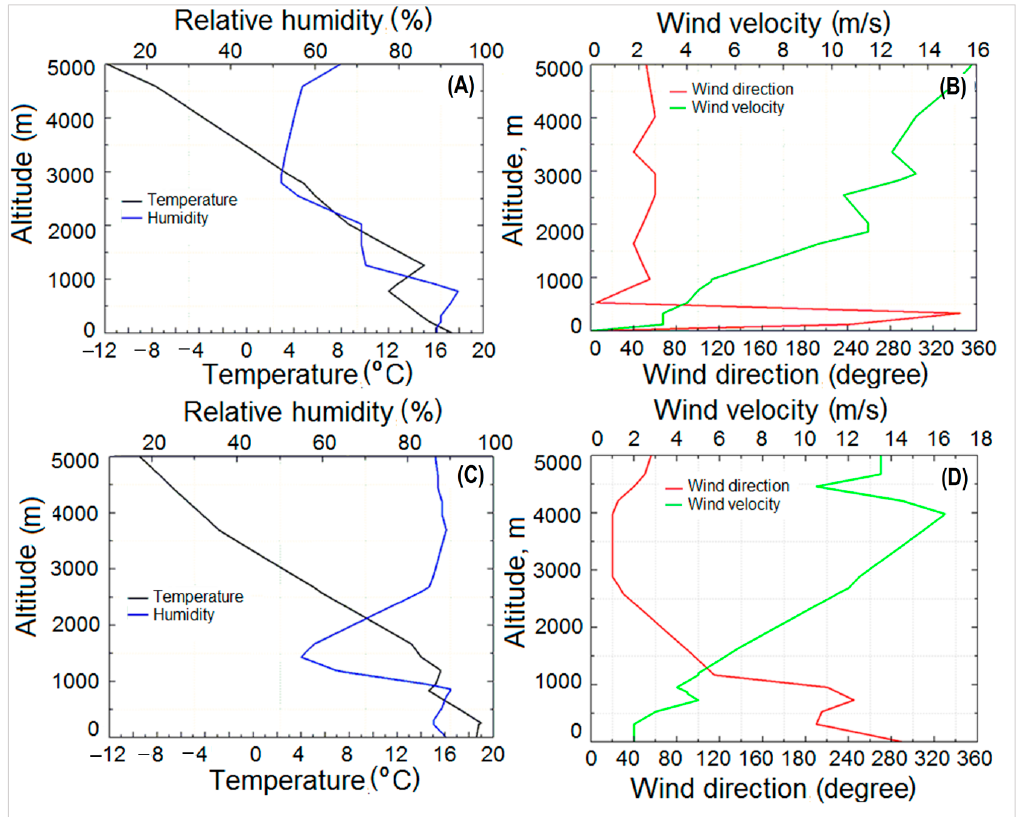
Figure 4. Dynamics of meteorological parameters in the atmosphere up to 5000 m in Central Baikal (weather station in Ust-Barguzin) at 8:00 on 29 July 2019 ( A , B ) and at 20:00 on 29 July 2019 ( C , D ) [33]. 3.2. Spatial Distribution of the Mass, M A ( μ g m − 3 ), and Number, N A (cm − 3 ), Concentrations of Aerosol Particles